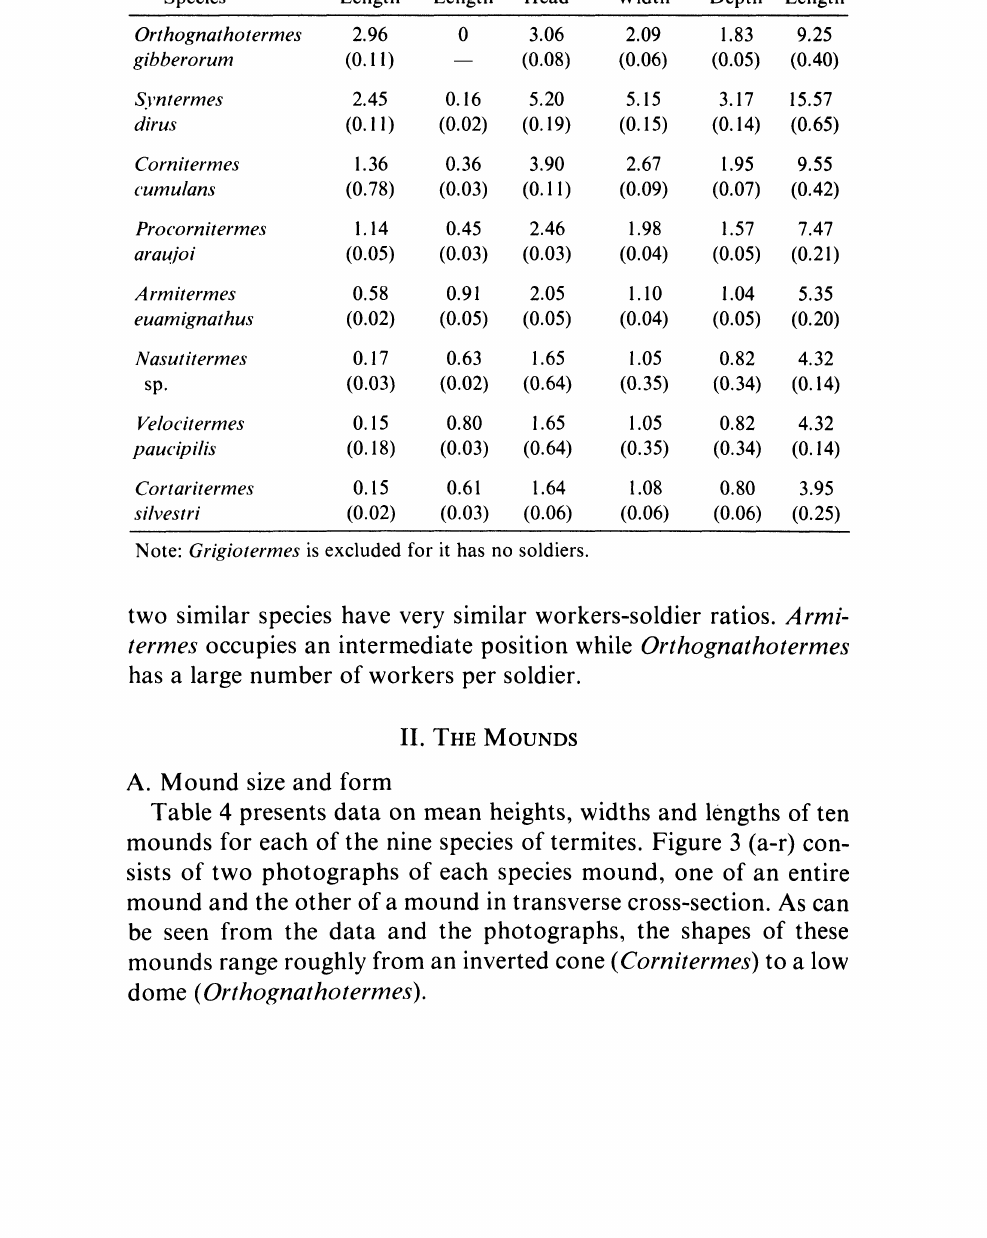
Table 2. Morphological measurements of soldiers (measurements expressed in millimeters; mean with standard deviation in parenthesis).